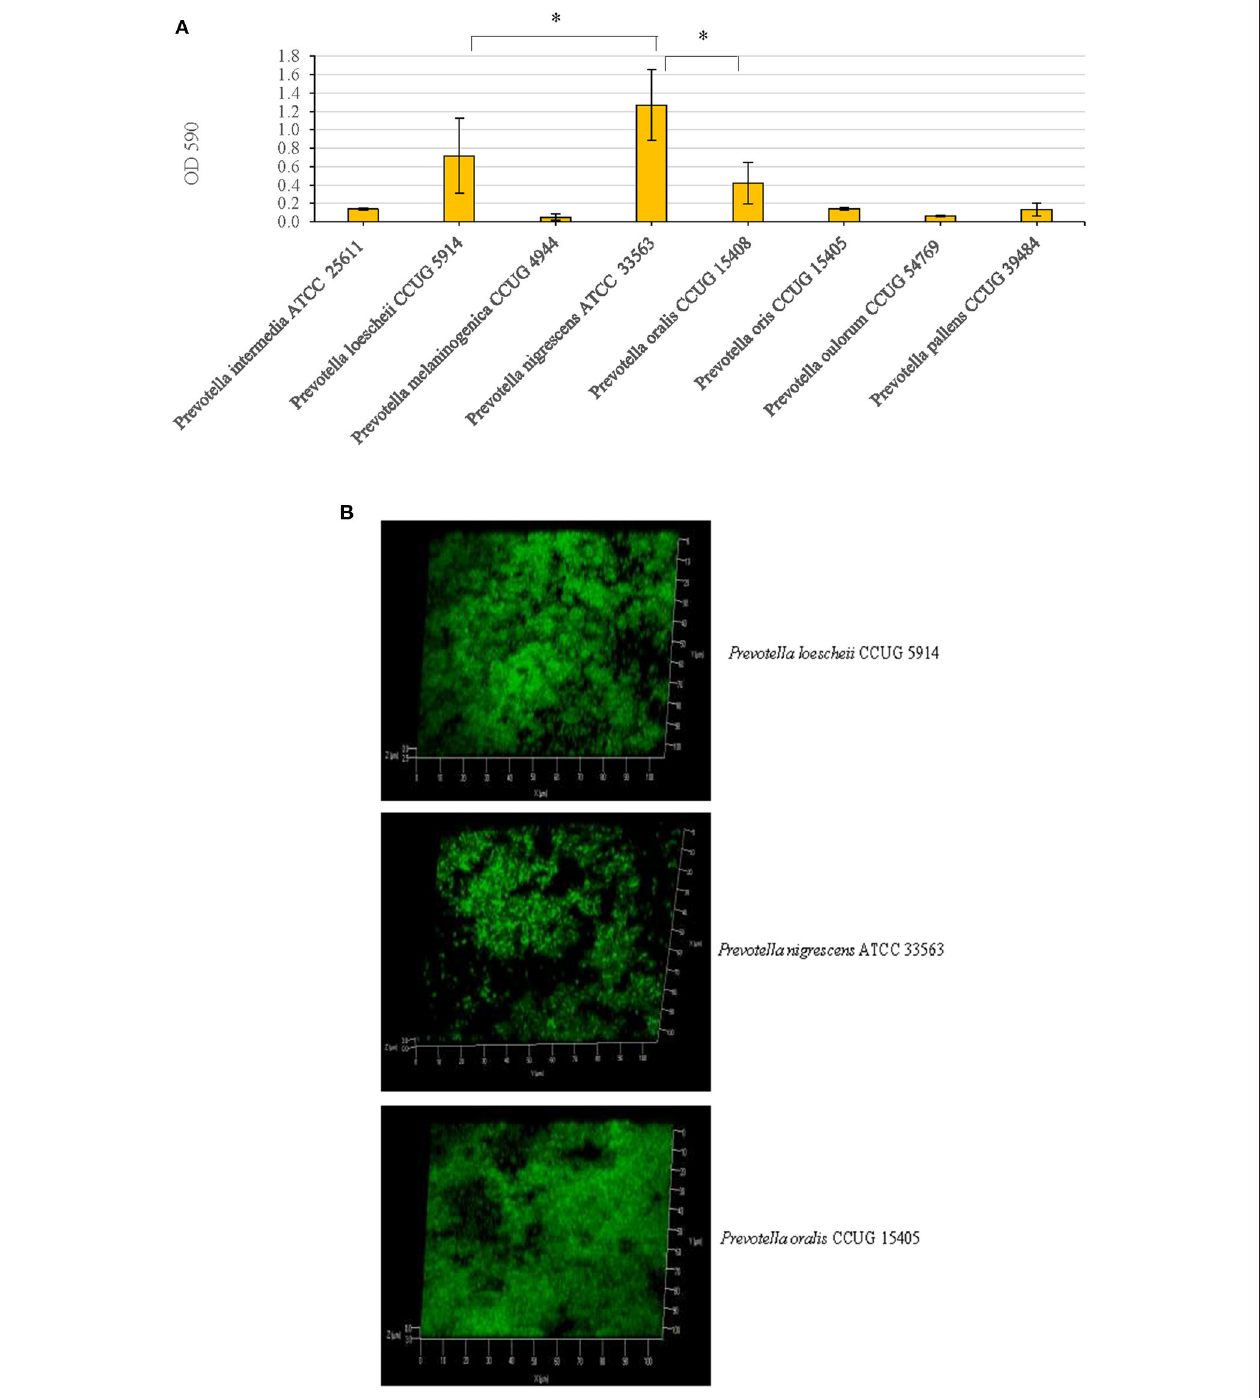
FIGURE 1 | (A) Biofilm forming abilities of eight Prevotella species. After growing static biofilm cultures for 3 days, a standard crystal violet staining technique was used for the quantification of the biofilm mass. Optical densities of the crystal violet solutions post-biofilm staining were measured at 590nm. * P < 0.005, Mann Whitney. (B) Confocal microscopy images of the biofilms. P. loescheii, P. nigrescens , and P. oralis biofilms which were cultured on glass chambers and stained with SYTO 9 dye. The images show x - y - z projections for a 3D view.